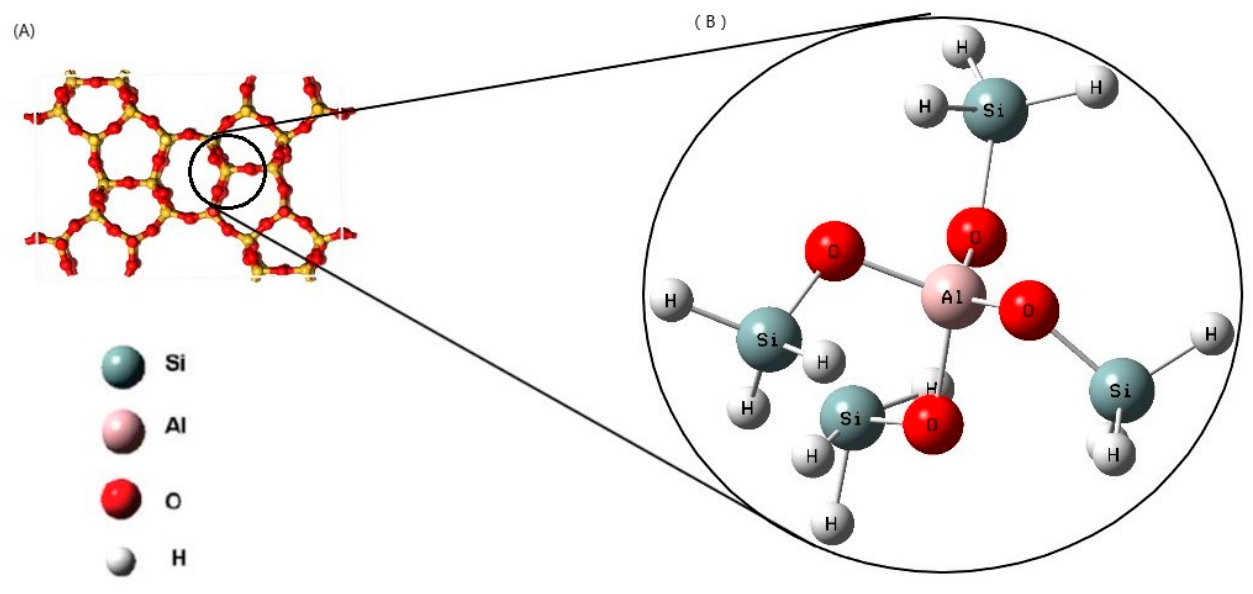
Figure 1. ( A ) ZSM-5 zeolite ( B ) optimized geometries for 5T ZSM-5 cluster.